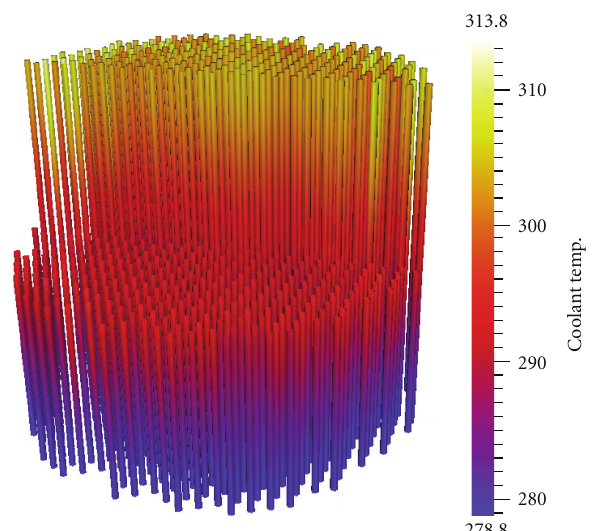
Figure 10: Instantaneous coolant temperature distribution in the active zone during a